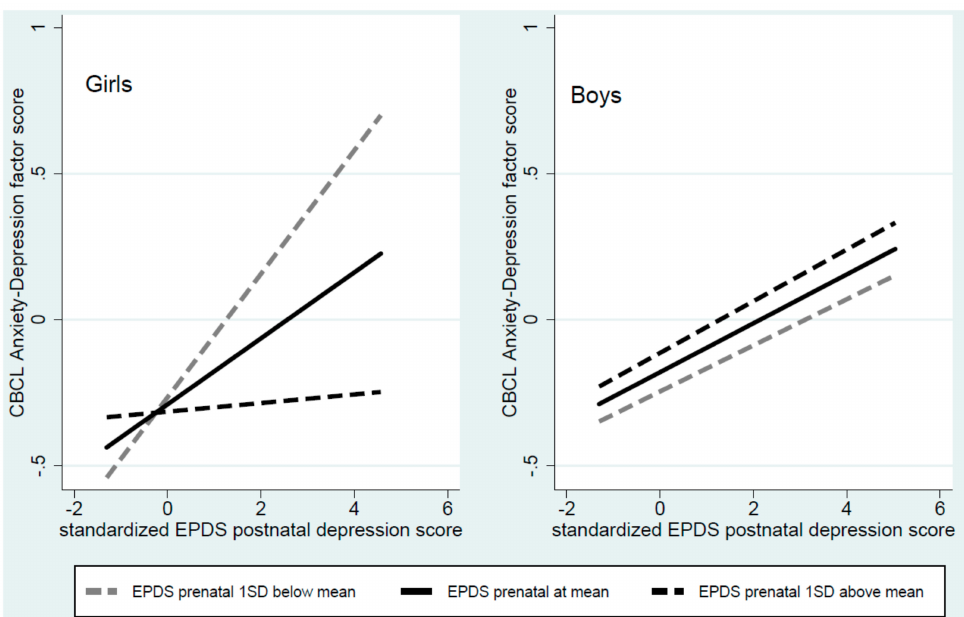
Figure 3. Regression lines for the interaction between pre- and post-natal depression and child anxious-depressed symptoms, showing the e ff ect of postnatal depression at the mean and one standard deviation on either side of the mean.